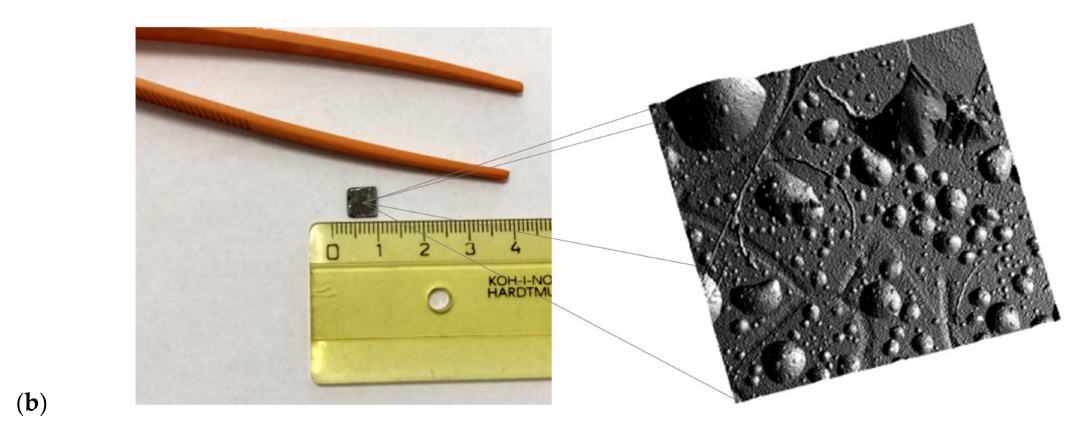
Figure 1. Sequence of atomic layer deposition (ALD) process including sub-cycles for bismuth and iron ( a ), and a sample with dimensions of 7 mm x 7 mm and an SPM-scanned image of a portion of the sample surface ( b ).